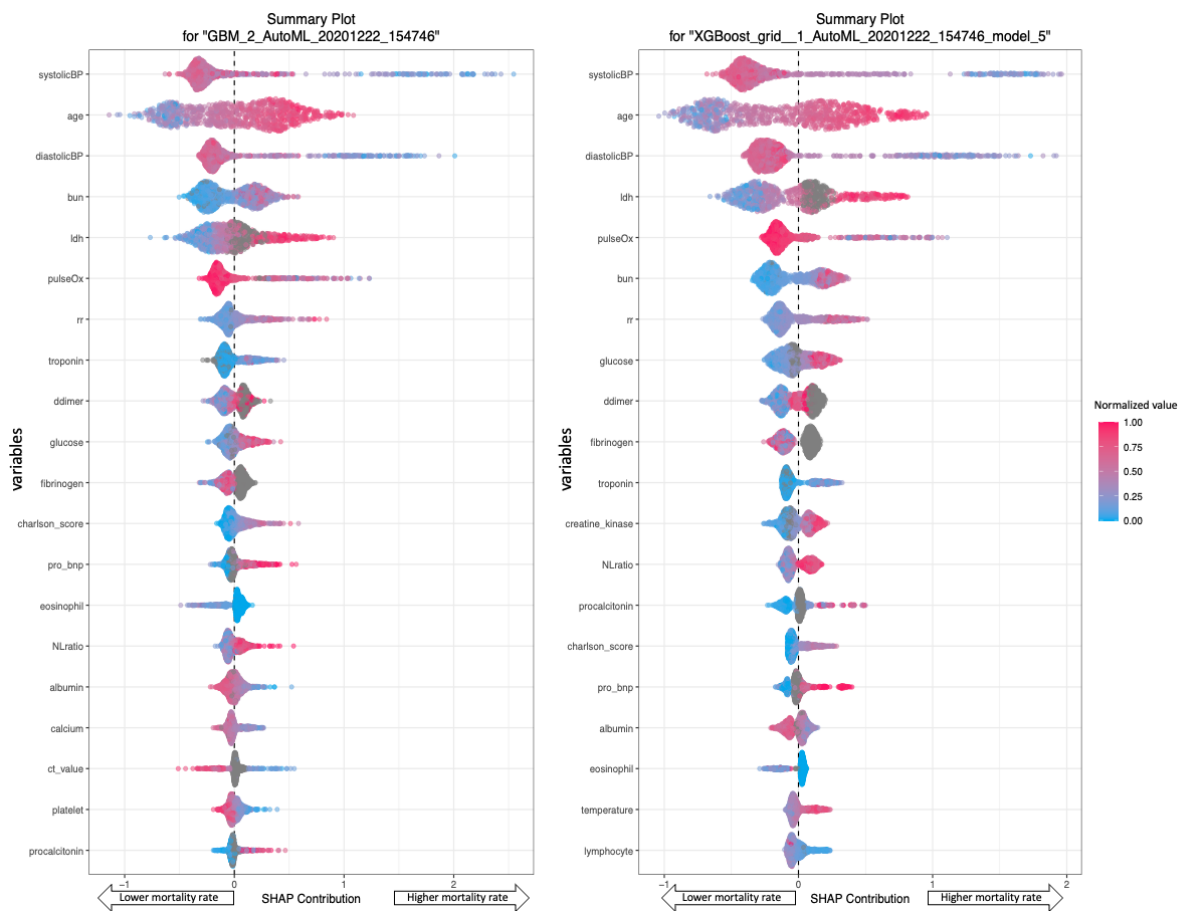
Figure 3. SHAP summary plots of the GBM and XGBoost models. According to the GBM and XGBoost models, higher systolic blood pressure levels (ie, red dots) were associated with a lower probability of death (ie, the left side of the vertical dotted line), and older age (ie, red dots) was associated with higher probability of death (ie, the right side of the vertical dotted line). BUN: blood urea nitrogen; charlson_score: charlson comorbidity index; ct_value: cycle threshold value; diastolicBP: diastolic blood pressure; GBM: gradient boosting machine; LDH: lactate dehydrogenase;